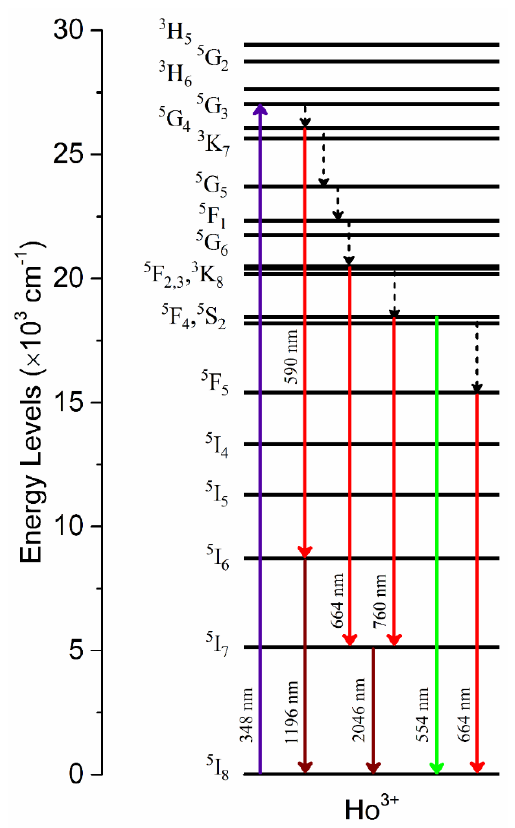
Figure 10. Energy level diagram of Ho 3+ ion and involved downshifting photoluminescence mechanism under 348 nm excitation. Solid upward arrow represents absorption transition while downward arrows represent emission transitions. Dotted downward arrows represent non-radiative relaxation.